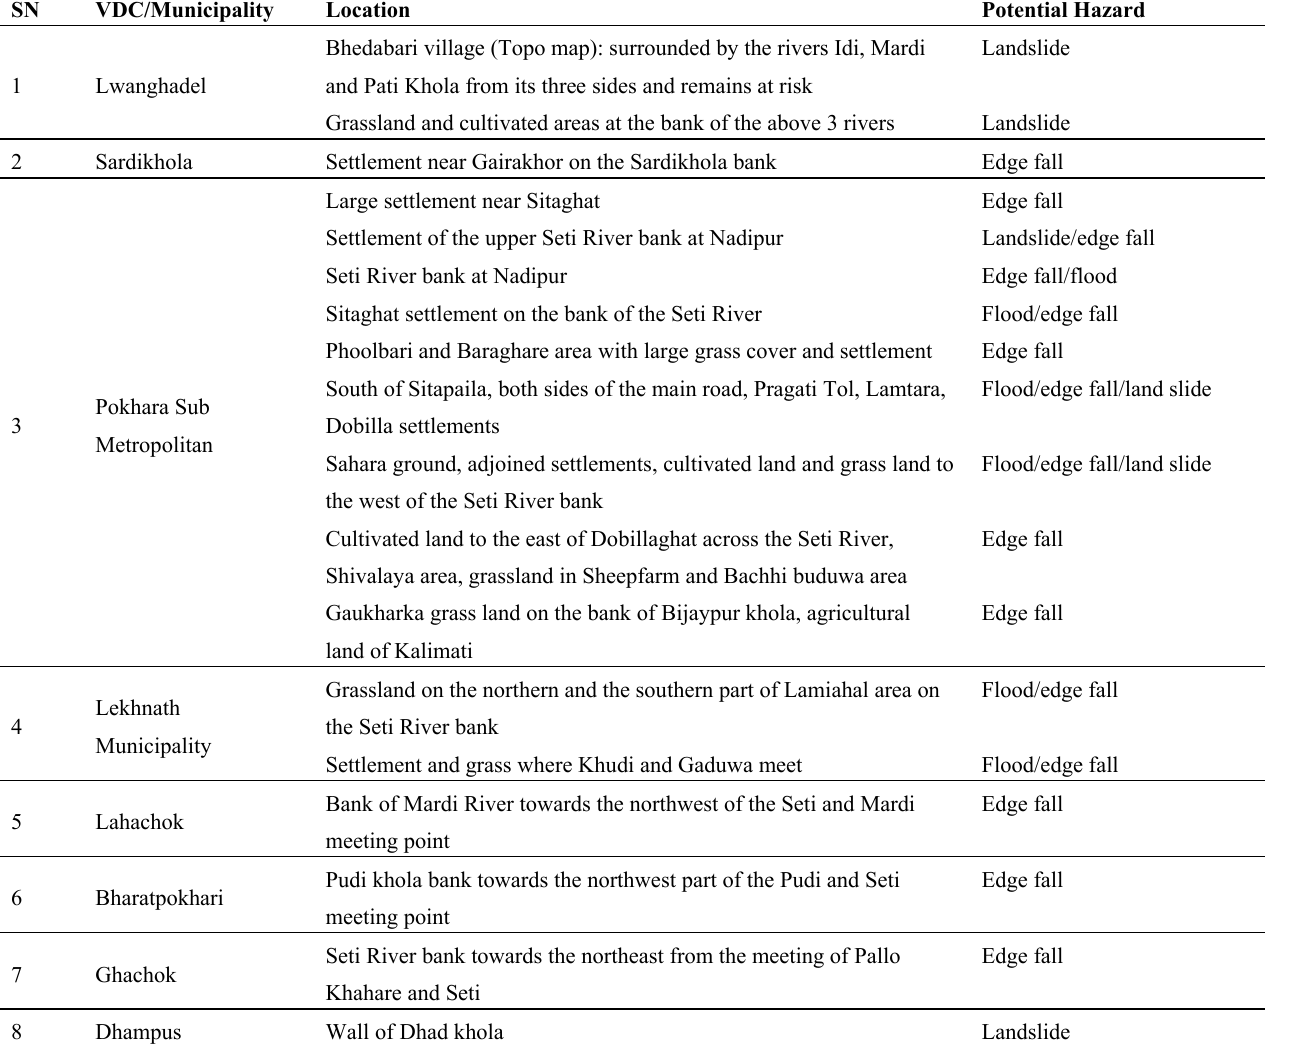
Table 4. Landslide and edge fall hazard-prone areas.